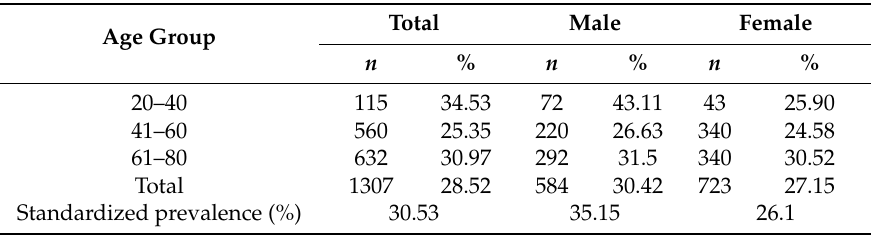
Table 2. The age-standardized prevalence of pre-diabetes stratified by sex and age.